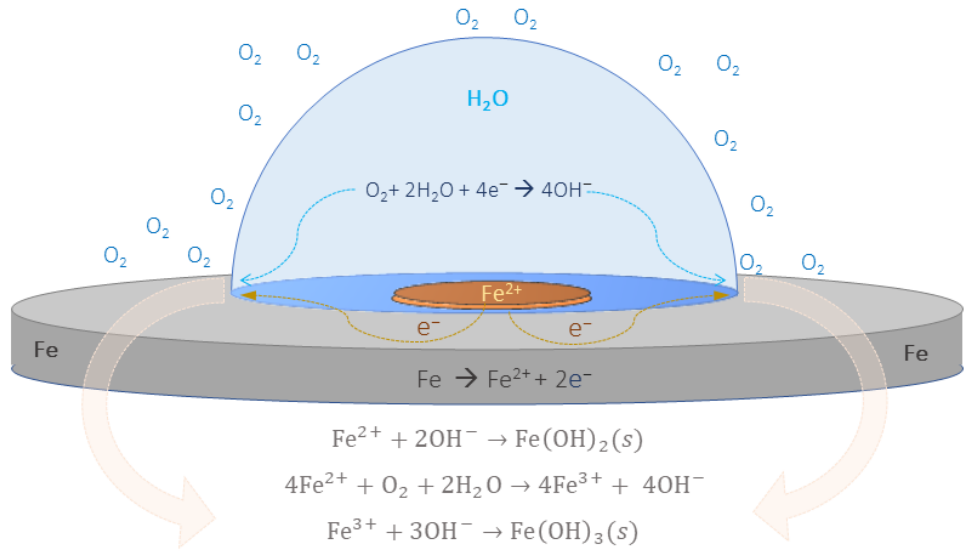
Figure 1. Schematic representation of oxidation of Fe and reduction of O 2 and rust formation.